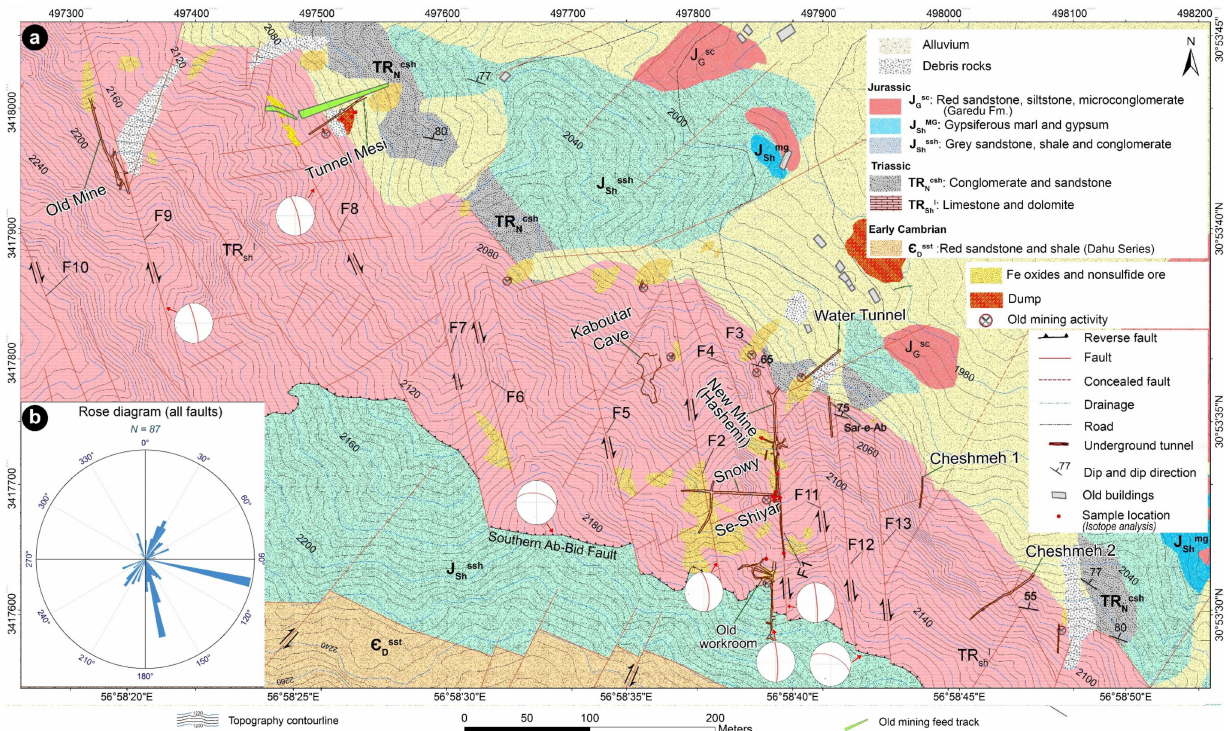
Figure 3. Geological map of the Ab-Bid deposit ( a , modified after [7]) and direction of faults in this area ( b ). Stereographic projections (in ( a )) show the orientations of major faults in the